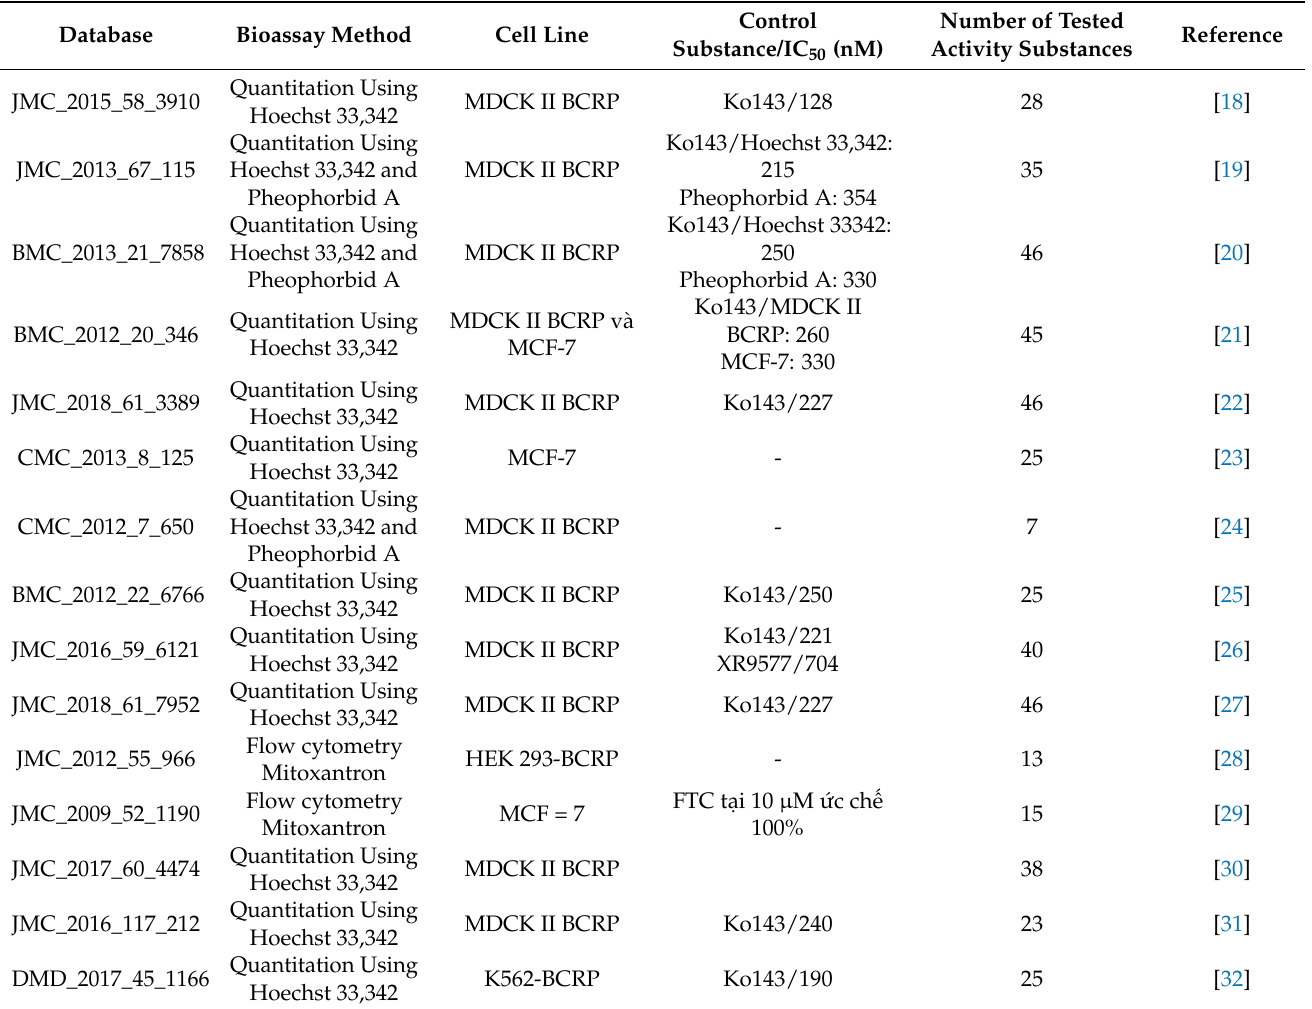
Table 9. List of databases used for pharmacophore modelling of ABCG2 inhibitors in this study.